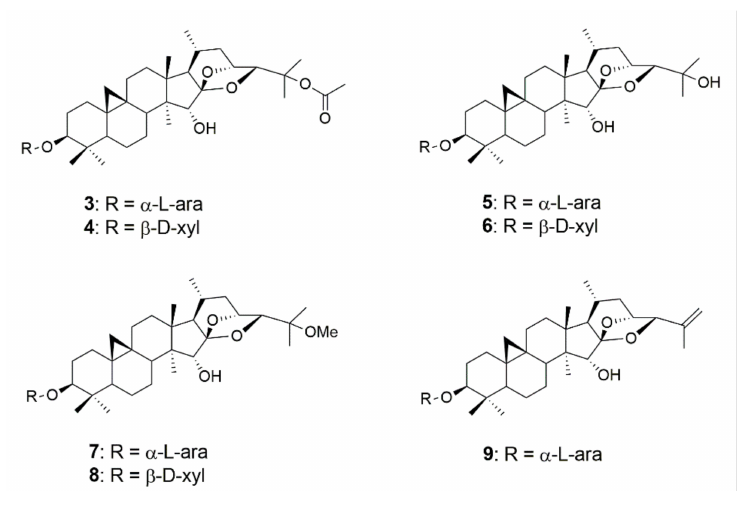
Figure 4. Chemical structures of ( 3 ), ( 4 ), cimigenol-3- O - α - l -arabinopyranoside ( 5 ), ( 7 ),